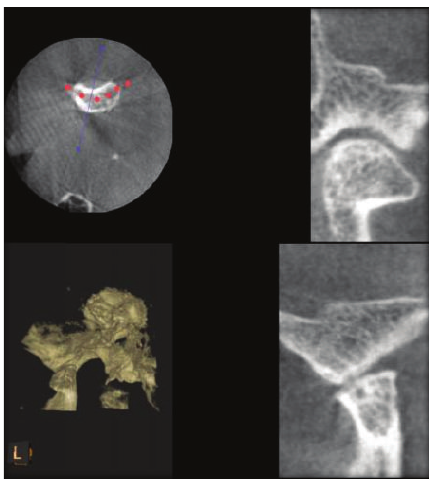
Figure 10: Pointed shape of condyle as seen in DVT.